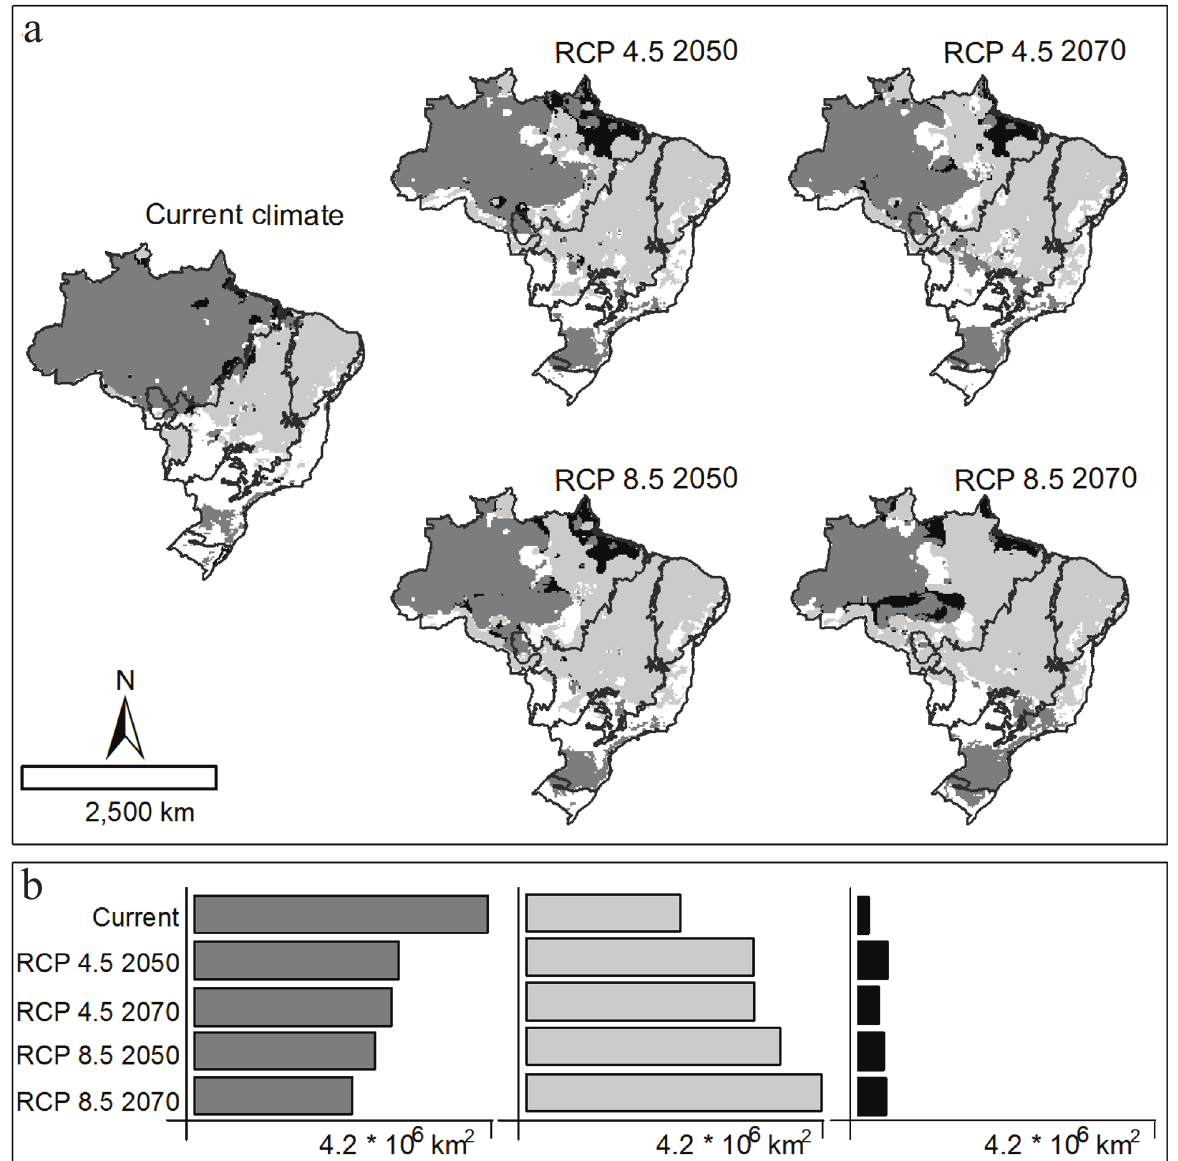
Figure 4 - Current and projected Brazilian native landcovers by category, climatic scenarios and time horizons: (a) spatial distribution and (b) area. Dark-gray represents closed forest, light gray is open vegetation, and black is the uncertainty of model distributions (i.e. locations where both landcovers overlap). In the maps in (a) , white areas are locations under anthropogenic use and were not evaluated